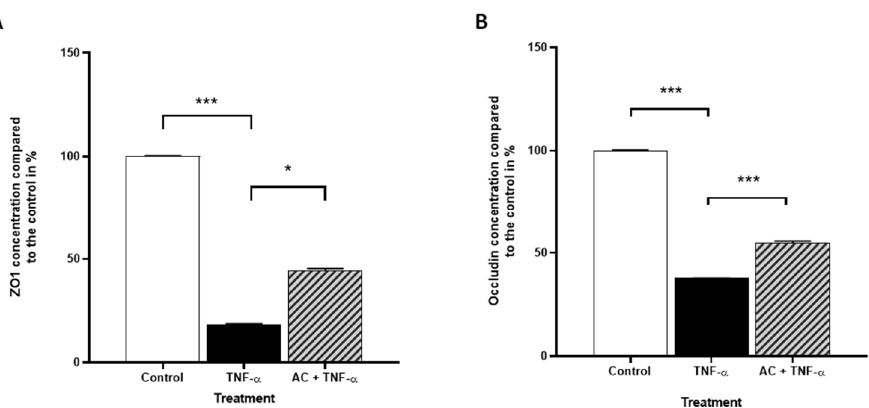
Figure 6. The effects of anthocyanin sour cherry extract on TNF- α induced ZO-1 and Occludin protein level. HUVECs were treated with TNF- α (10 ng/mL) and 85 µM AC + TNF- α (10 ng/mL) for 24 h. The protein level of ZO-1 ( A ) and Occludin ( B ) were determined by Flow Cytometry and the means were normalized to untreated control. Data are presented as mean ± SEMs. n = 3. The significance of differences between sets of data was calculated by ANOVA. * p < 0.05, *** p < 0.001.